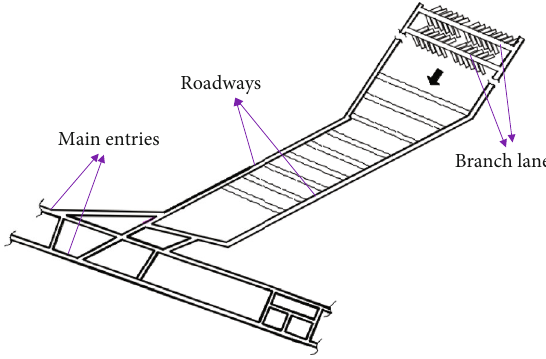
Figure 7: Roadway arrangement of short-wall working